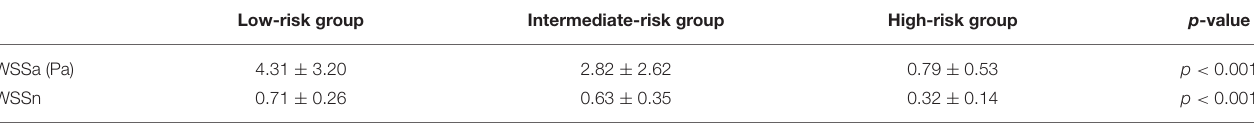
TABLE 2 | Aneurysmal hemodynamics in the low-, intermediate-, and high-risk groups.